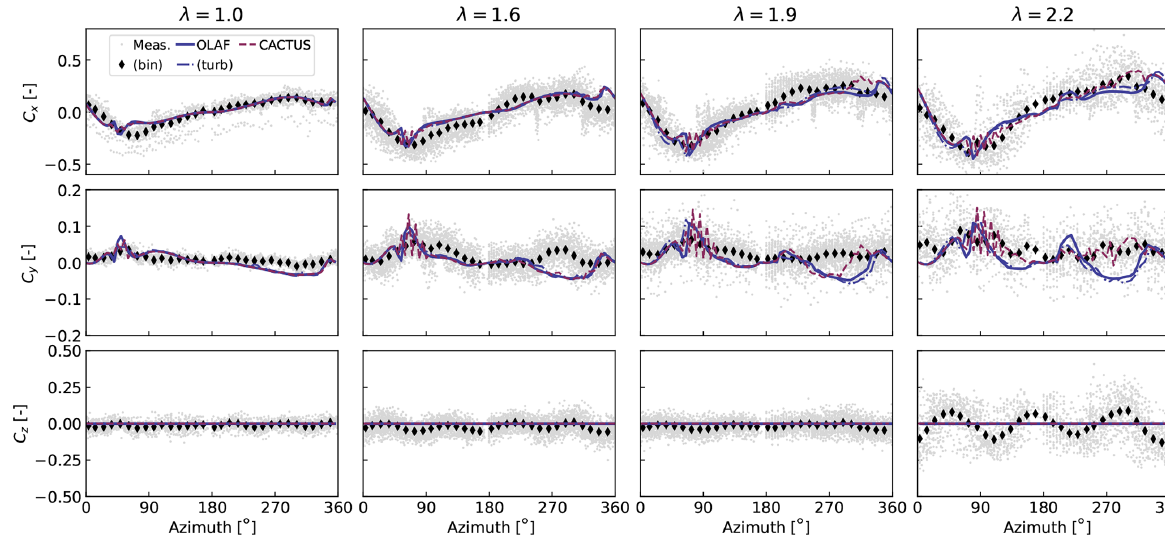
Figure 11. Force coefficients as measured and simulated on the VAWT model.